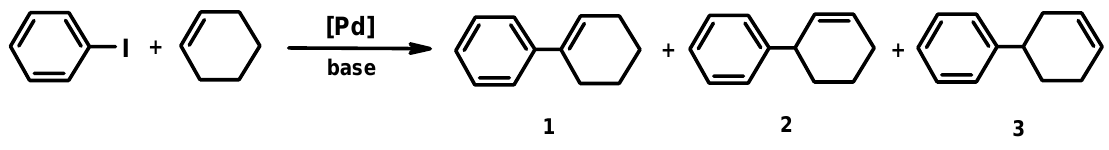
Figure 1. The Heck reaction of cyclohexene with iodobenzene.